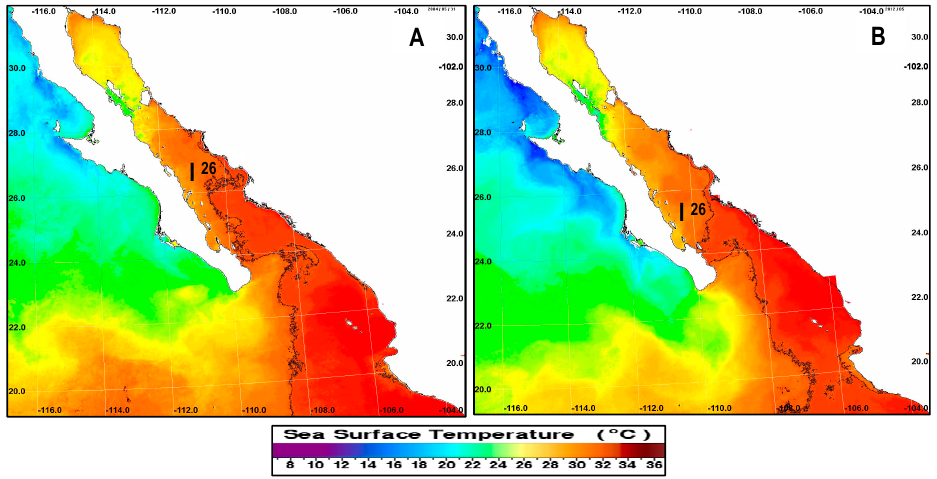
Figure 6. Satellite images of sea surface temperature °C of May 2004 ( A ) and 2012 ( B ) of the Gulf of California and temperature isolines of 26 °C (I 26) arriving to the central and southern coastal region of Sonora and the adjacent deep zone in the Gulf of California.